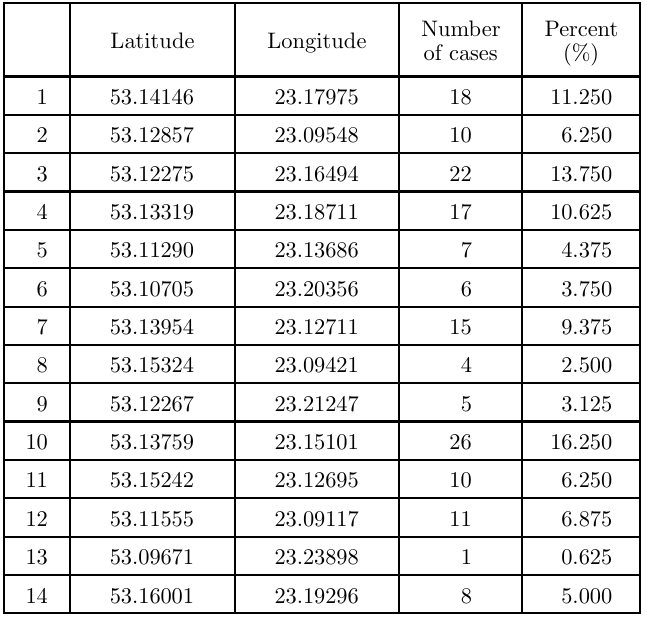
Table 1. Geographical coordinates of places where cases of cardiac arrest occurred the most